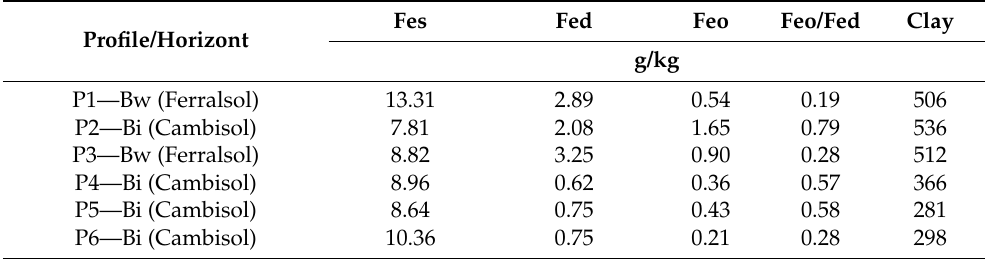
Table 5. Mean values Fe 2 O 3 contents extracted by sulfuric attack, dithionite-citrate-bicarbonate and ammonium oxalate, and the Feo/Fed